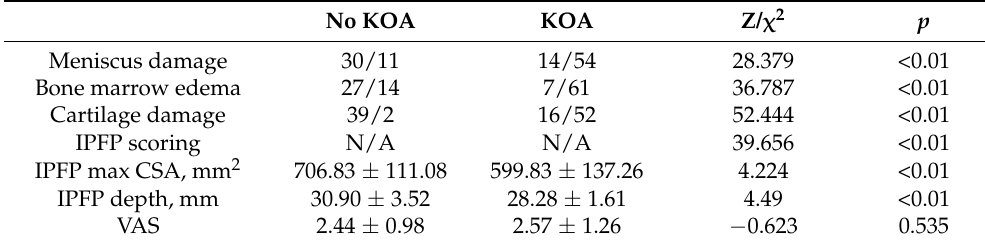
Table 4. The differences of parameters between KOA group and non-KOA group. No KOA KOA Z/ χ 2 p Meniscus